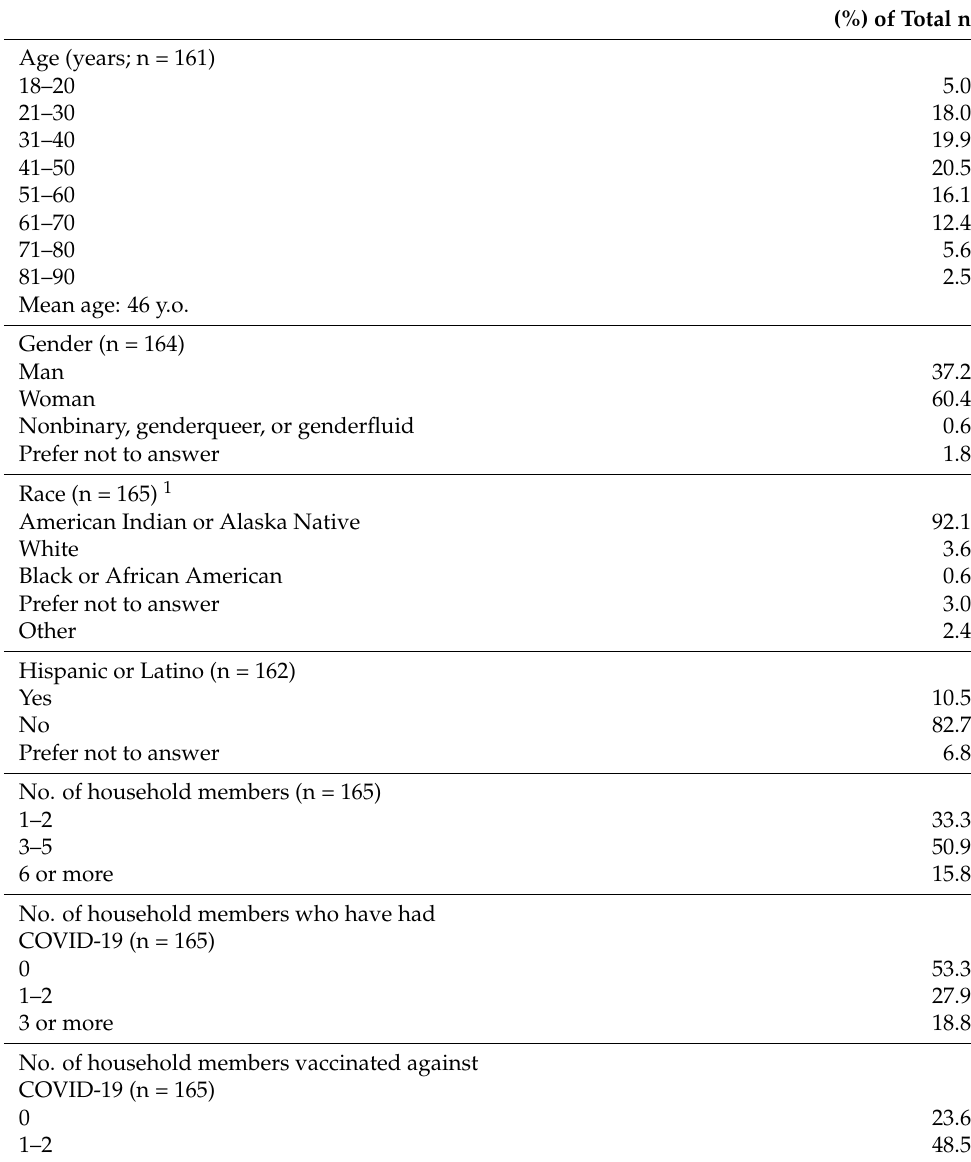
Table 1. Participant demographics at